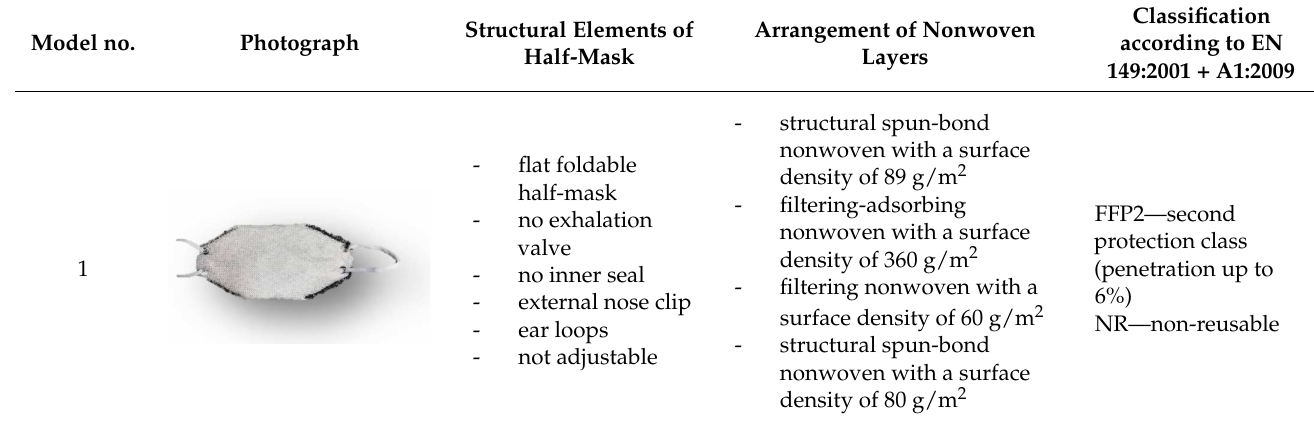
Table 1. Characteristics of the studied filtering half-masks.